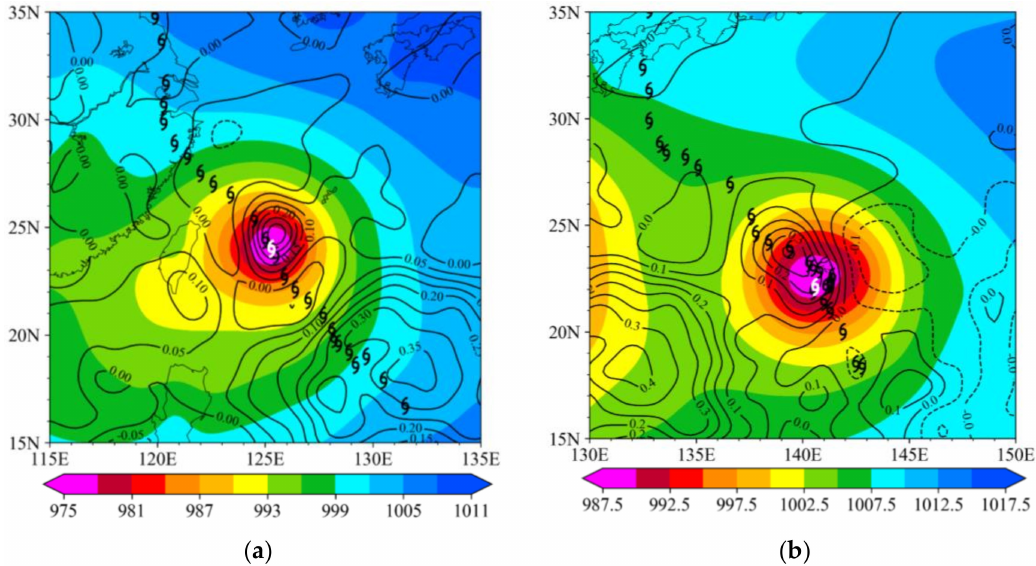
Figure 6. Spatial distribution of the SLP (shaded, units: hPa) for the CTRL experiment at 0900 UTC 8 August 2019 and the SLP di ff erence between ODS and CTRL (contours at 0.05 hPa interval, ODS–CTRL). The observed central positions of typhoons ( a ) Lekima and ( b ) Rosa are indicated by typhoon markers; the white typhoon markers represent the central positions at the current